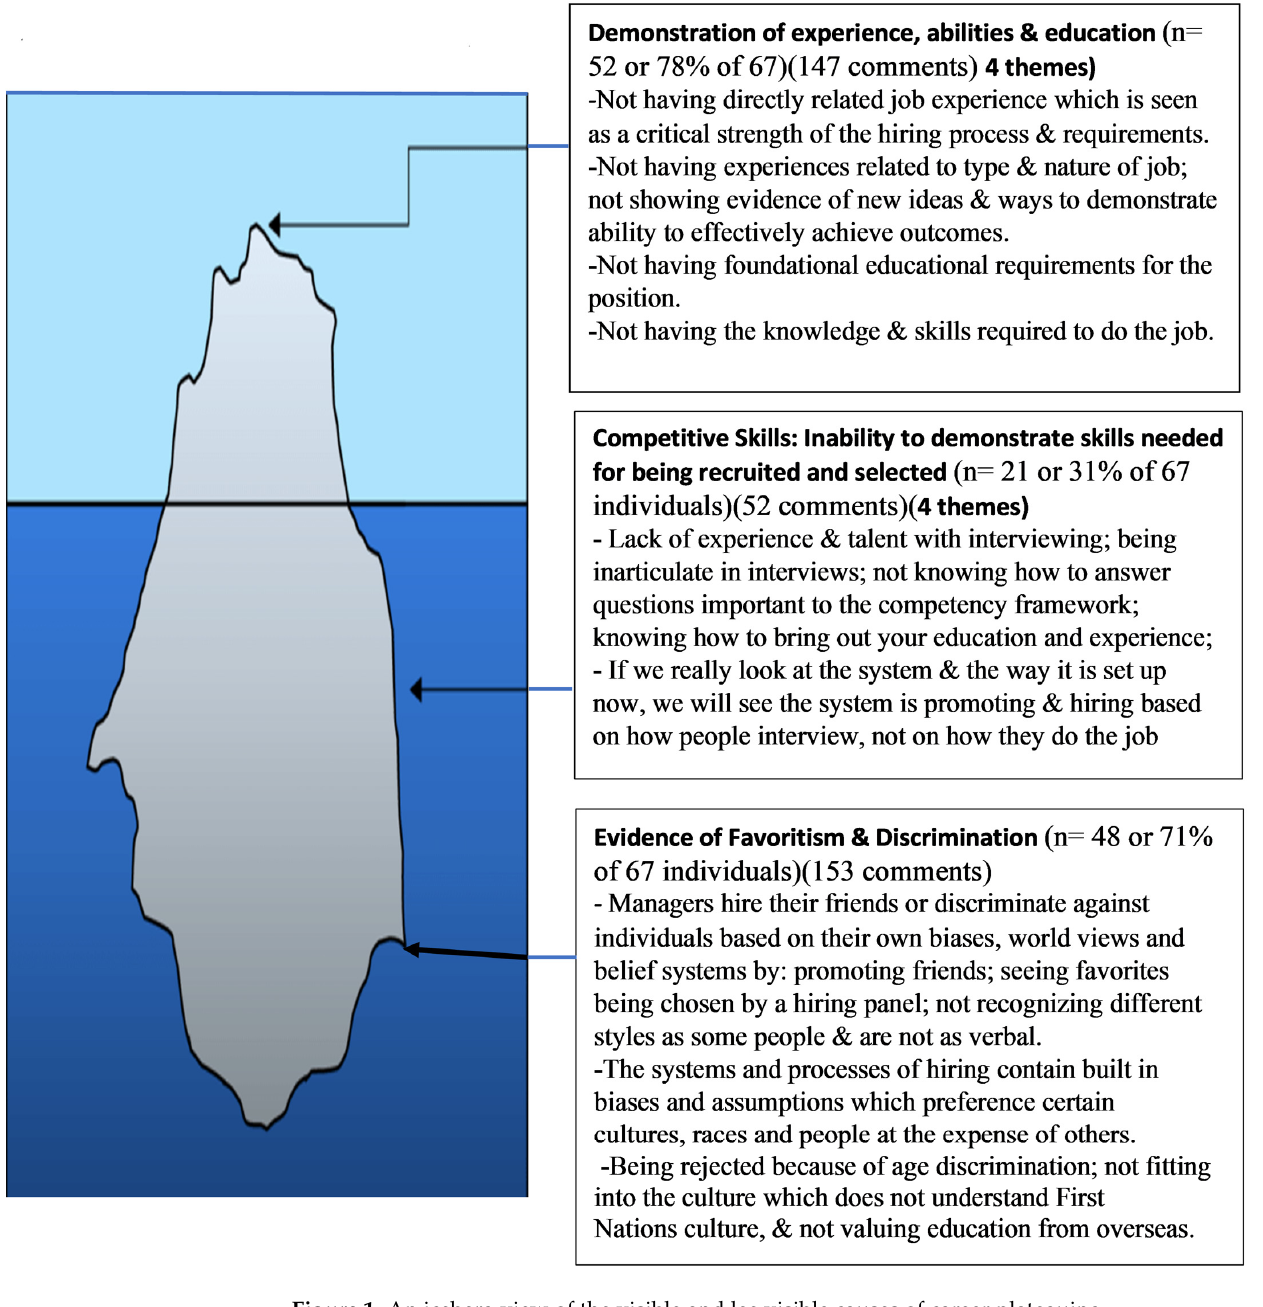
Figure 1. An iceberg view of the visible and lee visible causes of career plateauing.